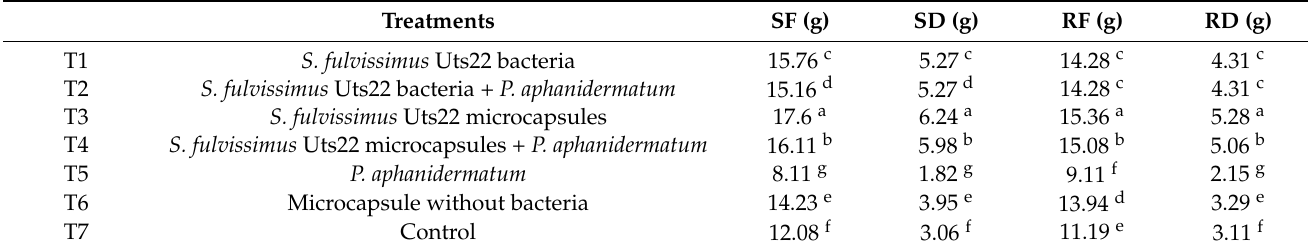
Table 3. Efficacy of S. fulvissimus Uts22 bacteria and its microcapsules on growth parameters in cucumber plants. Shoot fresh weight (SF), shoot dry weight (SD), root fresh weight (RF), root dry weight